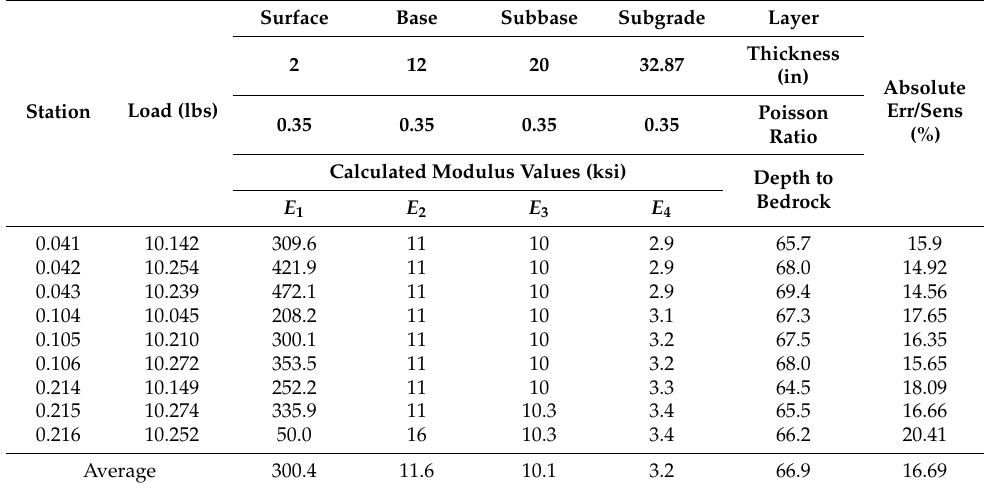
Table 3. Elastic modulus back-calculation results for the reinforced pavement in the program.